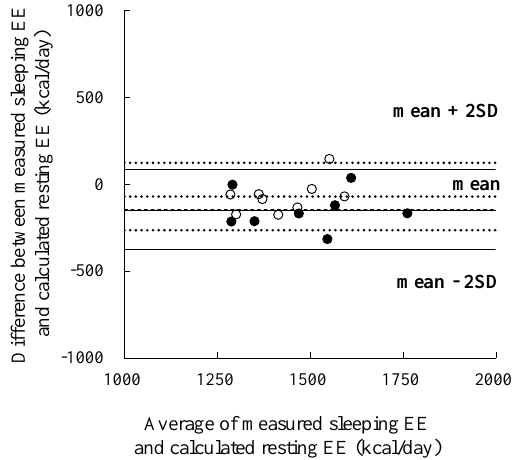
Figure 3. Bland-Altman analysis for comparing measured sleeping energy expenditure and estimated resting energy expenditure. EE: energy expenditure; REE: resting energy expenditure; ● : very fit runners; ○ : fit runners.